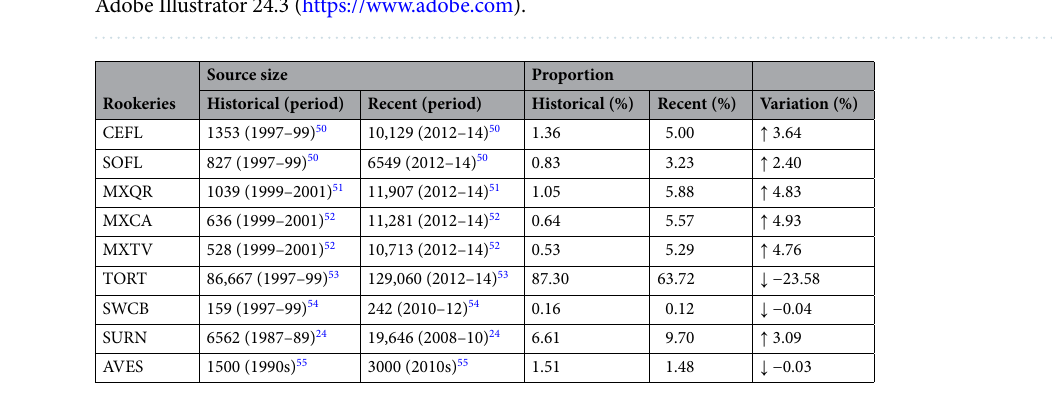
Table 1. Number of green turtle nests (source size) by rookery used in mixed stock models, relative size (proportion) in relationship to other rookeries, and variation of relative size between the two time periods (historical and recent). See Fig. 1 for site